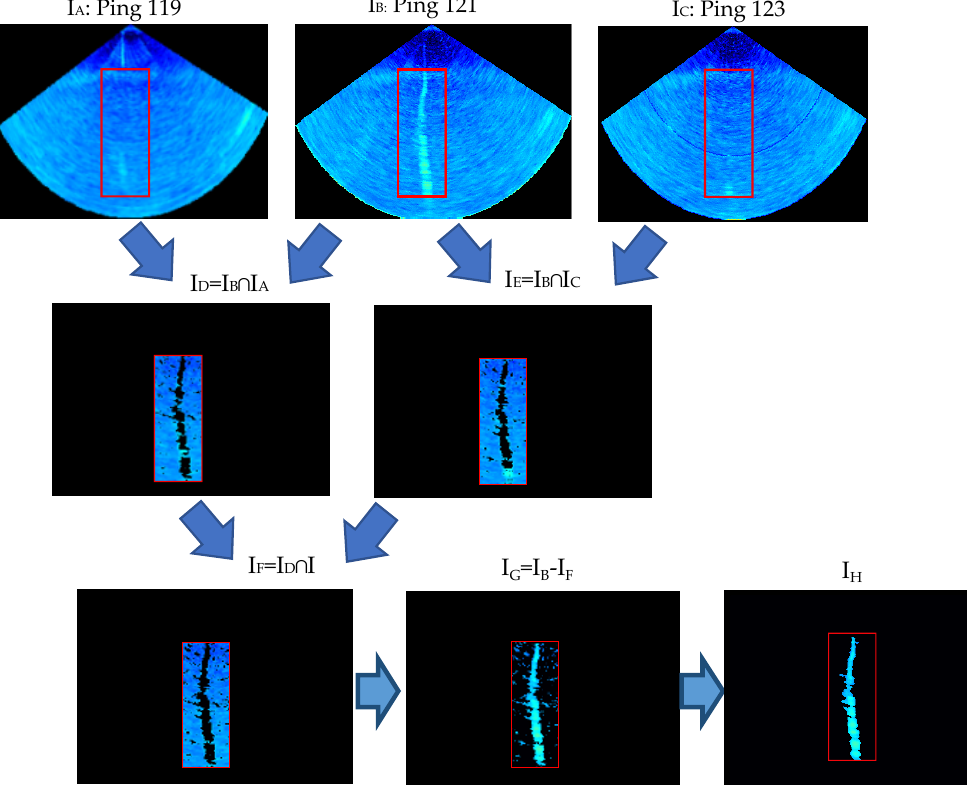
Figure 16. A target segmented from the MWC images by the proposed background differential segmentation algorithm. Among them, the red target boxes are generated by the target localization algorithm, and then the segmentation algorithm is based on the target-box regions, which improves the efficiency of the segmentation algorithm. Ping 119, 121 and 123, named as I A , I B and I C , are three raw successive MWC images. I denote the MWC image. Symbols ∩ and – represent the image intersection operation and subtraction operation.